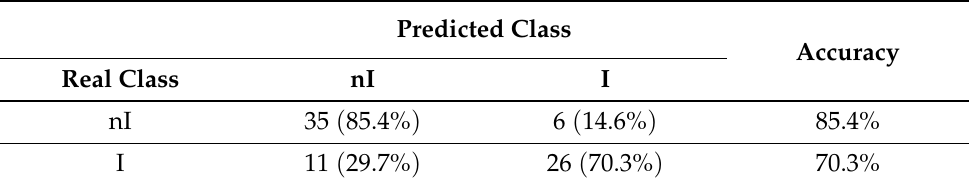
Figure 4. The ROC curves and AUC of the prediction models ( a ) Males and ( b ) Females. Table 6. Confusion matrix of the male prediction model. Accuracy is presented for each class (I and nI).